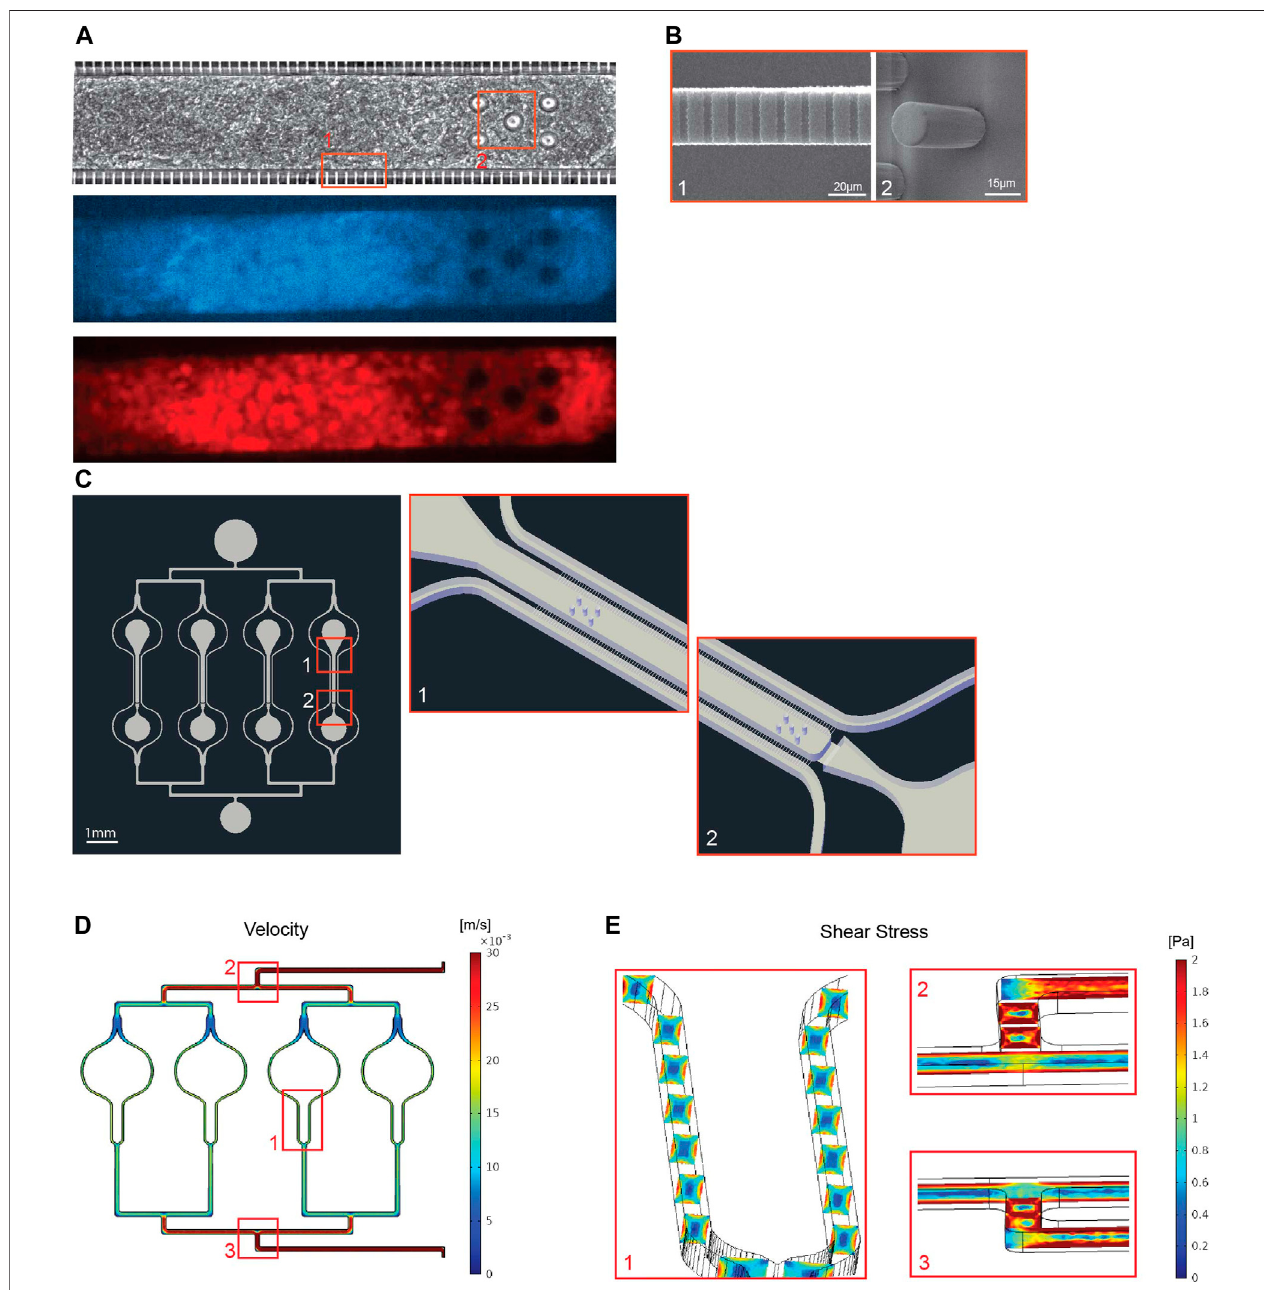
FIGURE 1 | Design of the multiplexed cardiac microphysiological system (MPS). (A) 20x images of a cardiac MPS loaded with 4,000 human induced pluripotent stem cell derived cardiomyocytes. Top image shows bright fi eld capture of the tissue, middle image shows GFP fl uorescence for calcium transient recordings, and bottomshowsFarRed fl uorescenceofthevoltagedyestaining. (B) ToleftSEMimageshowsthefenestrations(2 μ m × 2 μ mx20 μ m:h-w-l)requiredforprotectingtissuein the cell chamber from media fl ow-induced shear stress (panel E ) while enabling diffusion of nutrients. The right SEM image is a close up on pillars that keep the tissue fi ber spanned along the length of the cell chamber. Both images correspond to area from panel (A) denoted by one and two respectively. (C) llustration of the 4- plex tissue chamber MPS (left) and a three dimensional schematic (right) of top (1) and bottom (2) portions of one tissue chamber, which dimensions were 1300 μ m × 130 μ m with fi ve20 μ m diameter pillarsofat thetop and the bottom ofthechamber. (D) Illustrationofthe fl uidics velocity pro fi le obtainedwithCOMSOL Multiphysicsfor volume fl owrateof30 μ L/min, ranging from 30mm/sat the inlet and droppingto16mm/s equally around each cell chamber. (E) Close upshowing shear stresspro fi les in the media channels around the cell chamber (1), at the fi rst (2) and last (3) bifurcation of the multiplex chip.